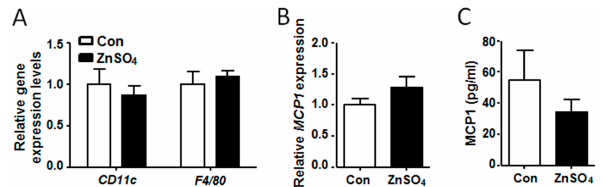
Figure 5. Chronic zinc supplementation did not alter the expression of macrophage marker genes and MCP1 in perirenal adipose tissue. ( A ) The expression of CD11c and F4/80 in perirenal adipose tissue; ( B ) The expression of MCP1 in perirenal adipose tissue; ( C ) Serum MCP1 levels. Data were shown as mean ± SEM. Con, control group; ZnSO 4 , zinc sulfate-supplemented group.